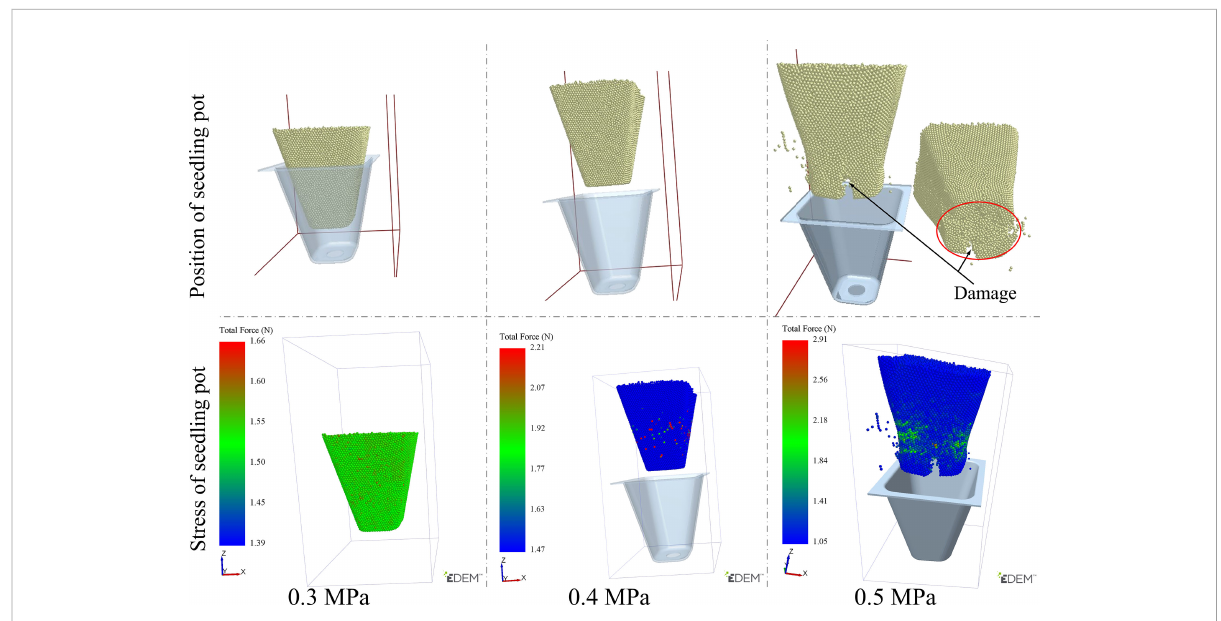
FIGURE 10 The results of fl uid-discrete body